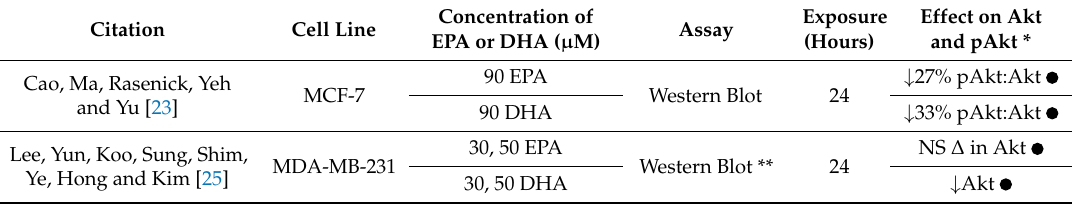
Table 12. Comparison of EPA and DHA on Akt and pAkt in human BC cell